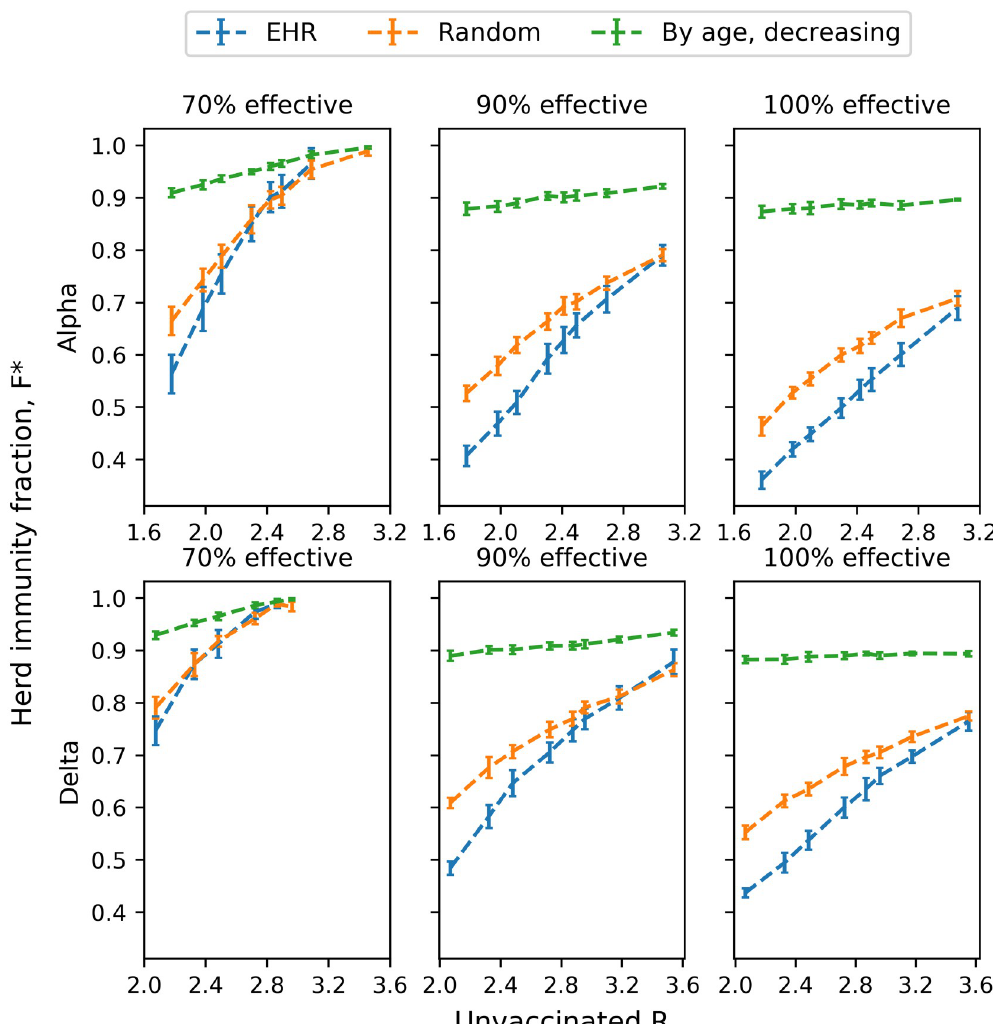
Fig 3. Herd immunity thresholds according to R 0 and choice of strategy. Fraction of population requiring vaccination in order to reach herd immunity ( R < 1) according to each strategy and R 0 for an unvaccinated population. Each data point and corresponding errorbar represent the mean R and standard deviation of 20 duplicate simulations, respectively.